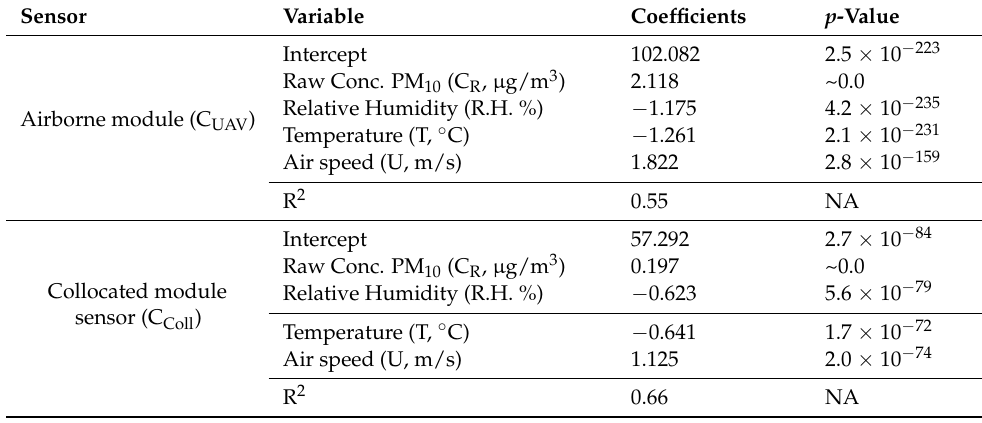
Table 2. Resulting coefficients for variables of equations for dust monitoring sensors with their p -value and confidence